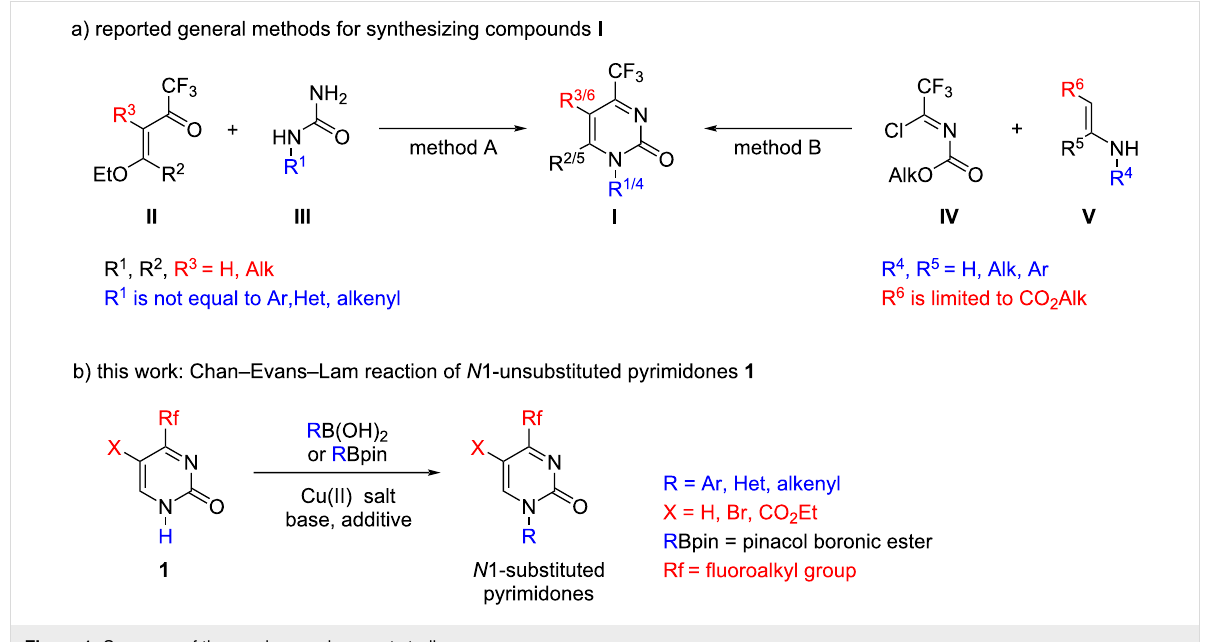
Figure 1: Summary of the previous and present